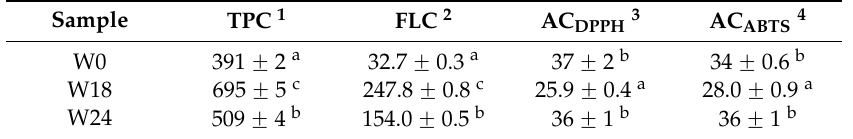
Table 1. Phytochemical content and antiradical capacity of wines analysed (mean ˘ SE).